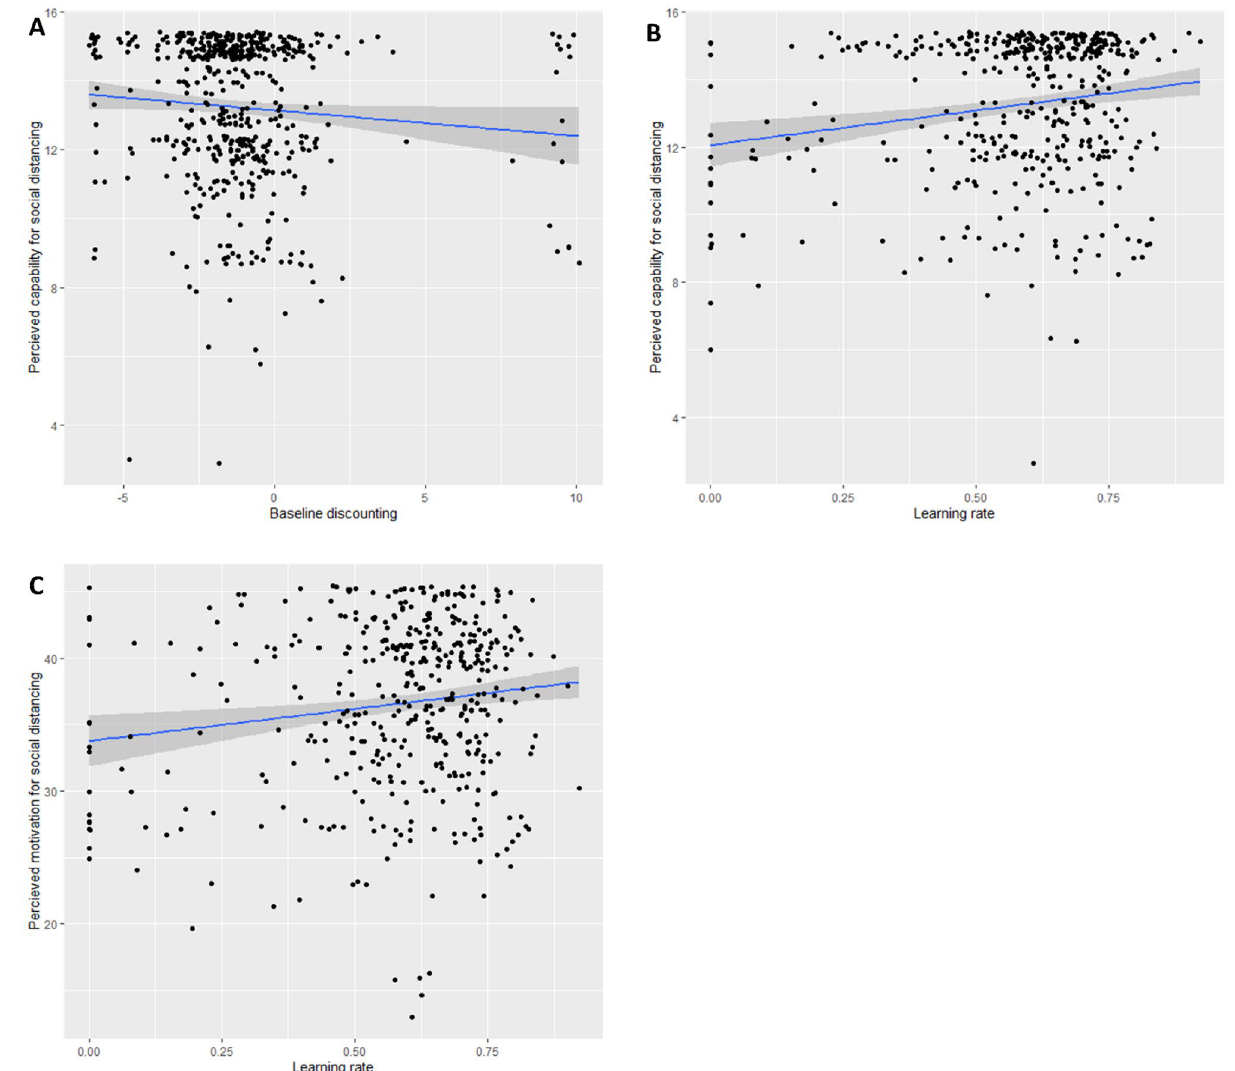
Figure 3. ( A ) Steeper delay discounting predicted higher levels of self-reported capability to enact social distancing during the established phase of the pandemic (T2). ( B ) Lower learning rate predicted lower levels of self-reported capability for social distancing during the established phase of the pandemic (T2). C) Higher learning rate also predicted higher levels of self-reported motivation for social distancing. Regression lines are highlighted in